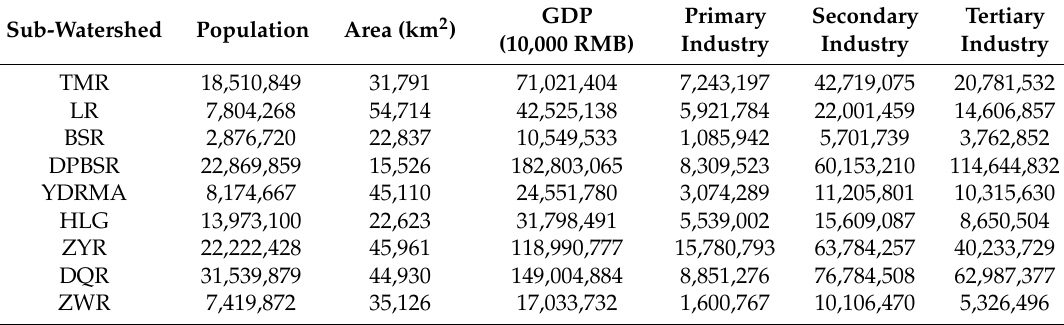
Figure 1. Distribution of sampling sites in the Haihe River Basin. Table 1. Population and economy data of different watersheds in the Haihe Basin (2011).